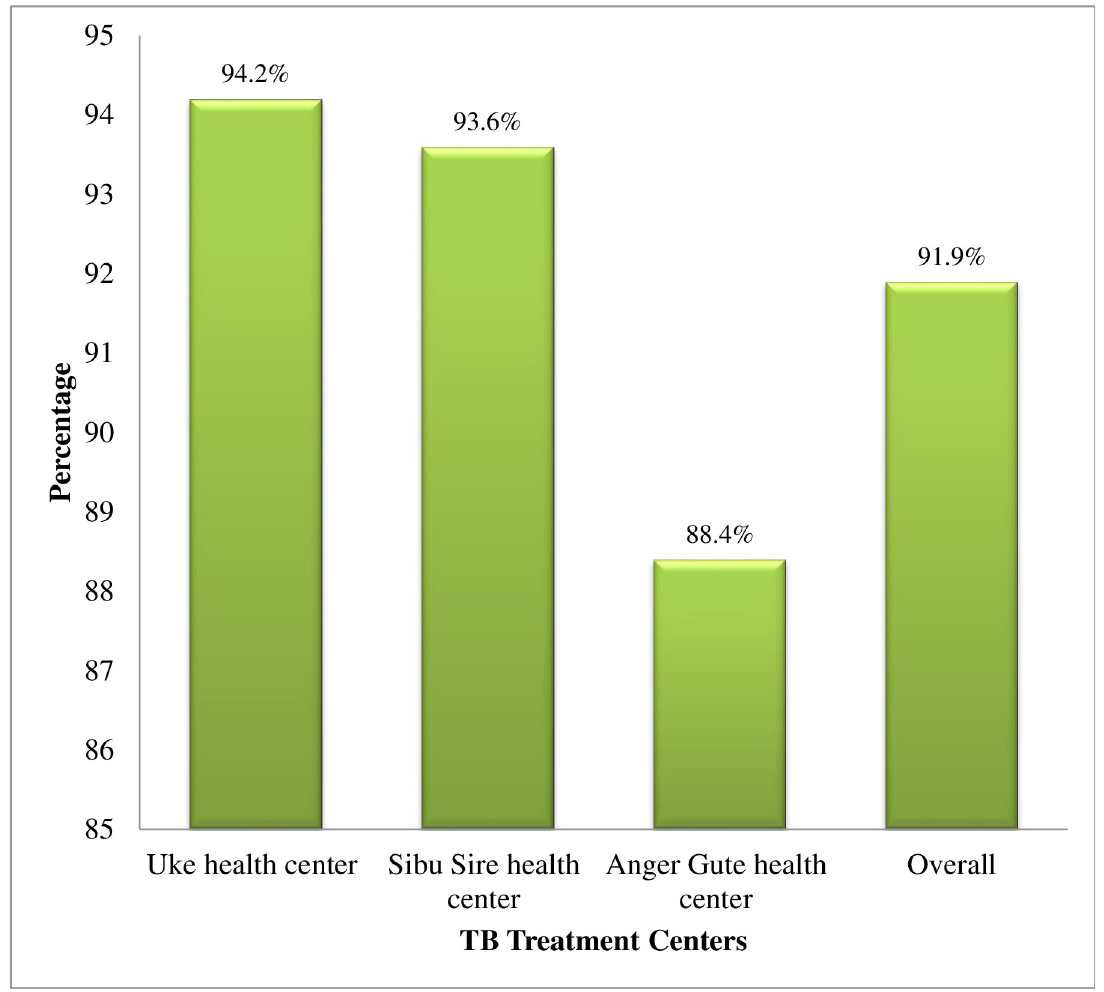
Fig 4. Treatment success outcomes of TB patients at three TB treatment centers in East Wollega from 2012 to 2016.